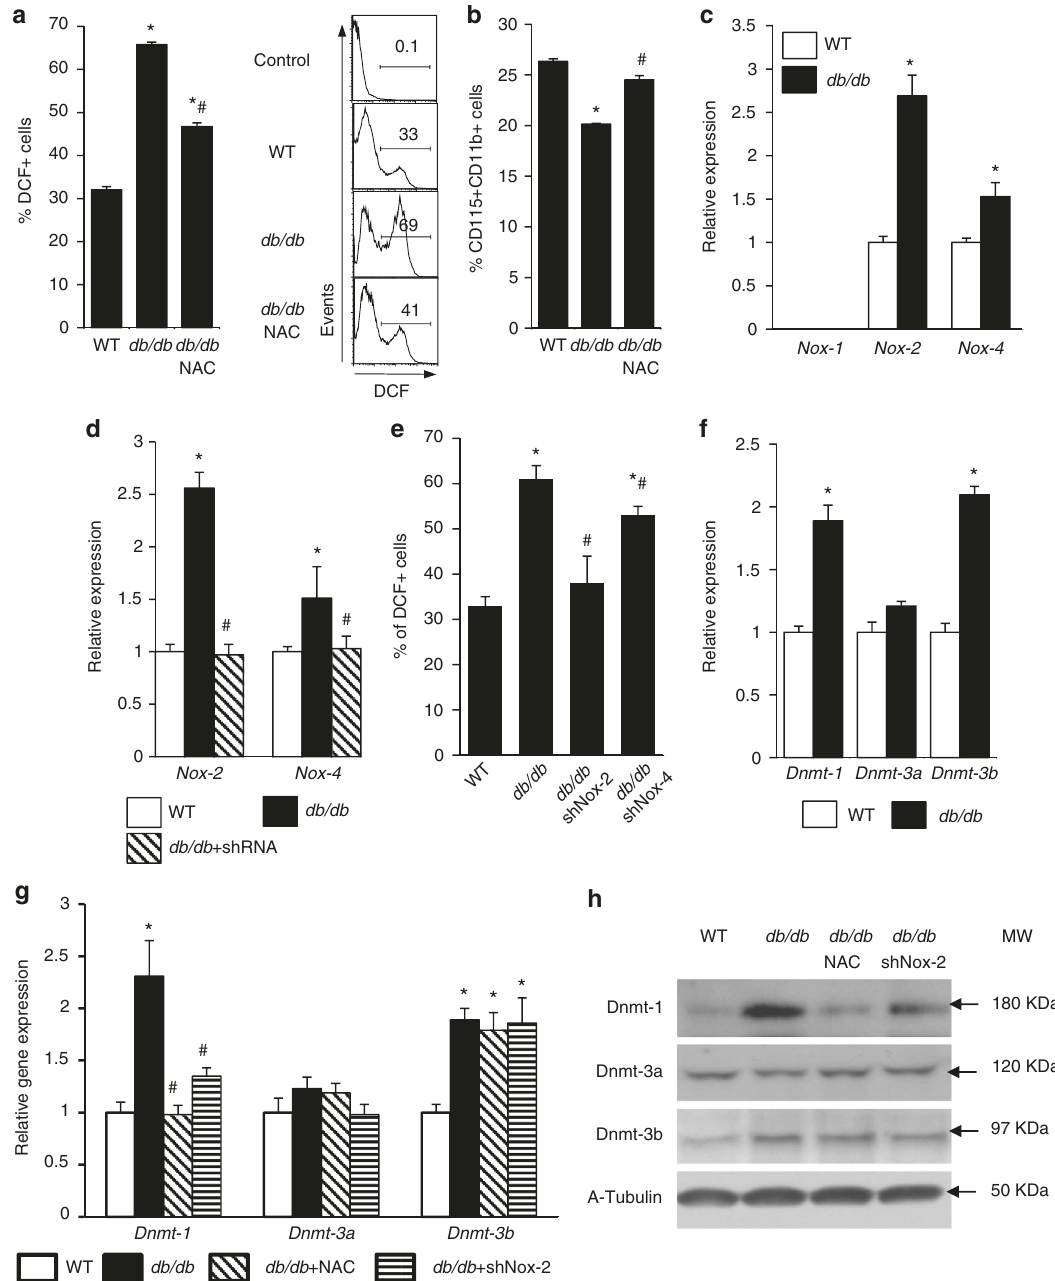
Fig. 4 Nox-2-dependent increase in Dnmt1 expression. Quanti fi cation by fl ow cytometry of a DCF positive cells ( n = 6, * p < 0.05 vs. WT; # p < 0.05 vs. db/ db ). b Monocytes concentration in bone marrow ( n = 6, * p < 0.05 vs. WT; # p < 0.05 vs. db/db ). c NADPH oxidase gene expression ( n = 6, * p < 0.05 vs. WT). d Nox-2 and Nox-4 gene expression after knockdown of Nox-2 or Nox-4 ( n = 6, * p < 0.05 vs. WT; # p < 0.05 vs. db/db ). e Quanti fi cation of DCF positive cells after knockdown of Nox-2 or Nox-4 ( n = 6, * p < 0.05 vs. WT; # p < 0.05 vs. db/db ). f Dnmts gene expression ( n = 6, * p < 0.05 vs. WT). g Dnmts expression after knockdown of Nox-2 or NAC antioxidant treatment ( n = 6, * p < 0.05 vs. WT; # p < 0.05 vs. db/db ). h Dnmts protein levels